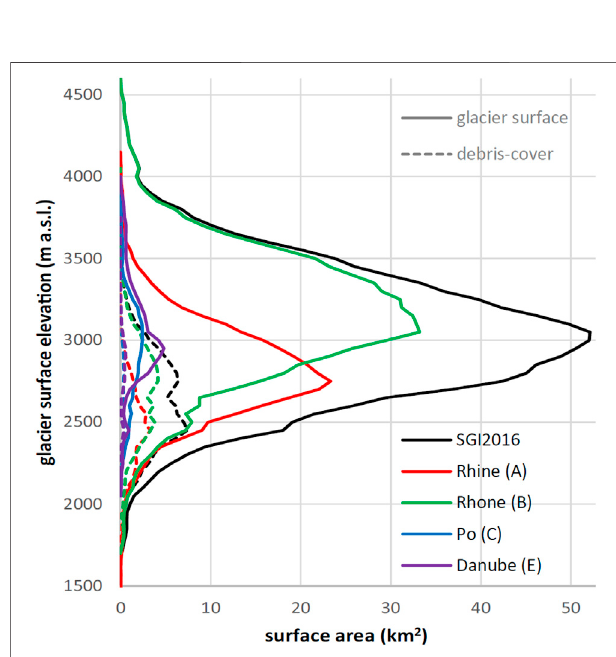
FIGURE 9 | Glacier surface and debris-cover distribution in hypsometric bands of 50 m for the four major river catchments and entire Swiss Alps.